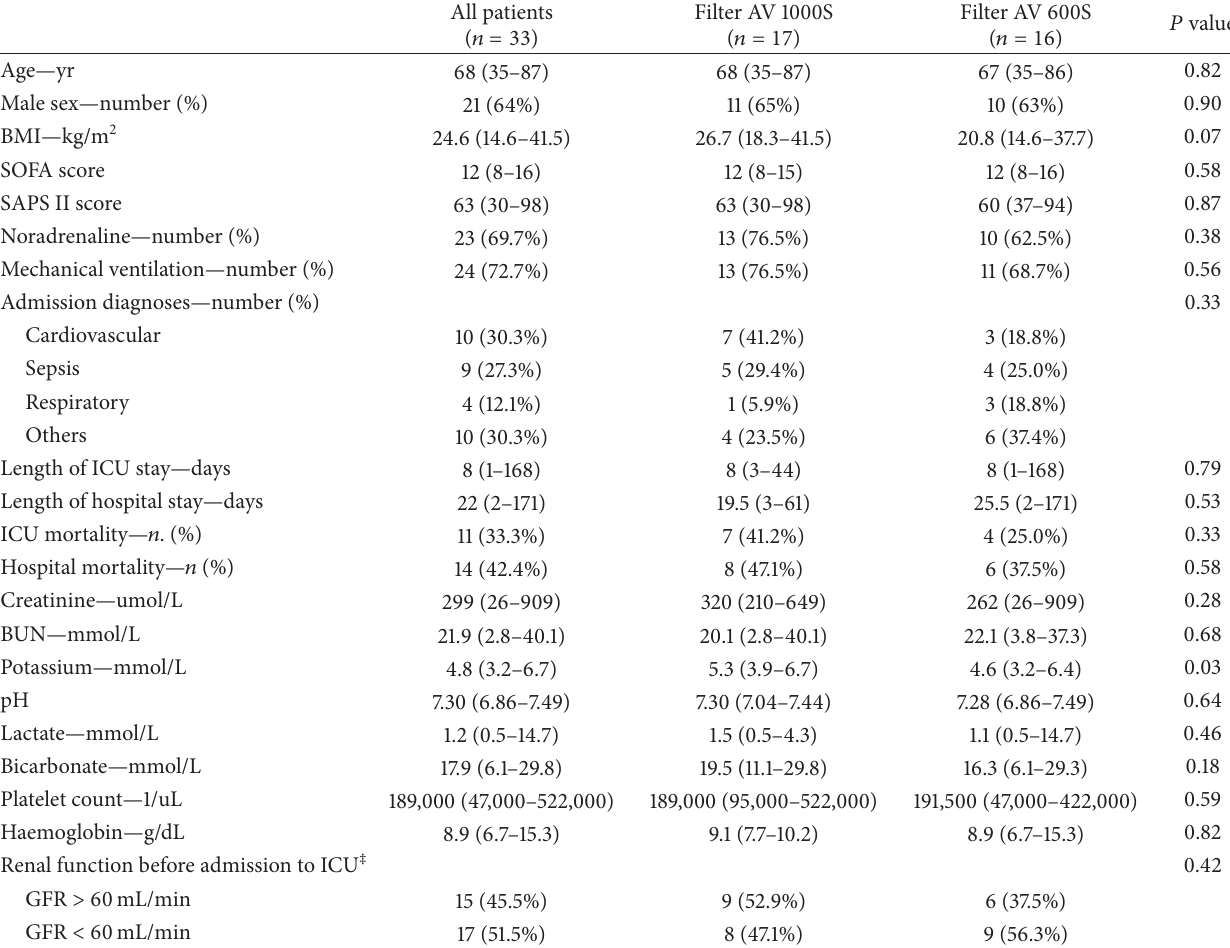
Table 1: Baseline patient characteristics and laboratory parameters at CVVHDF start.